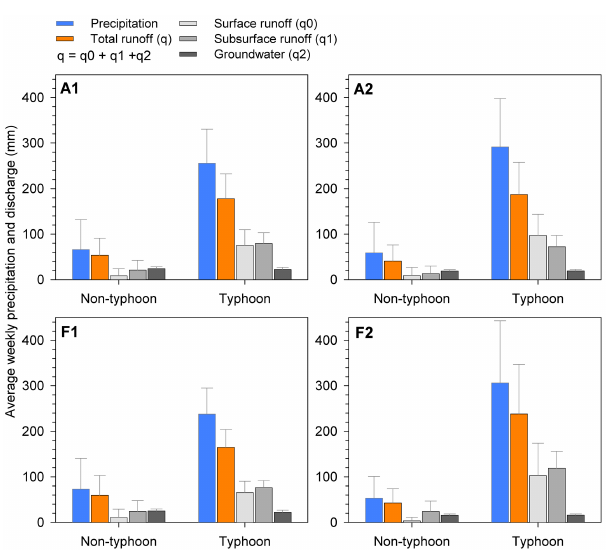
Table 1. Runoff ratio of the four watersheds during typhoon and non-typhoon periods. Watersheds Typhoon period Non-typhoon period Surface runoff: Total runoff: Surface runoff: Total runoff: precipitation precipitation precipitation precipitation A1 0.29 0.69 0.12 0.80 A2 0.33 0.64 0.15 0.69 F1 0.27 0.69 0.14 0.76 F2 0.33 0.78 0.06 0.81